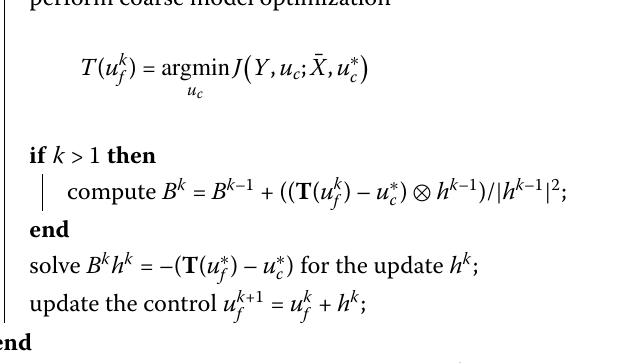
Algorithm 1: Aggressive Monte Carlo space mapping